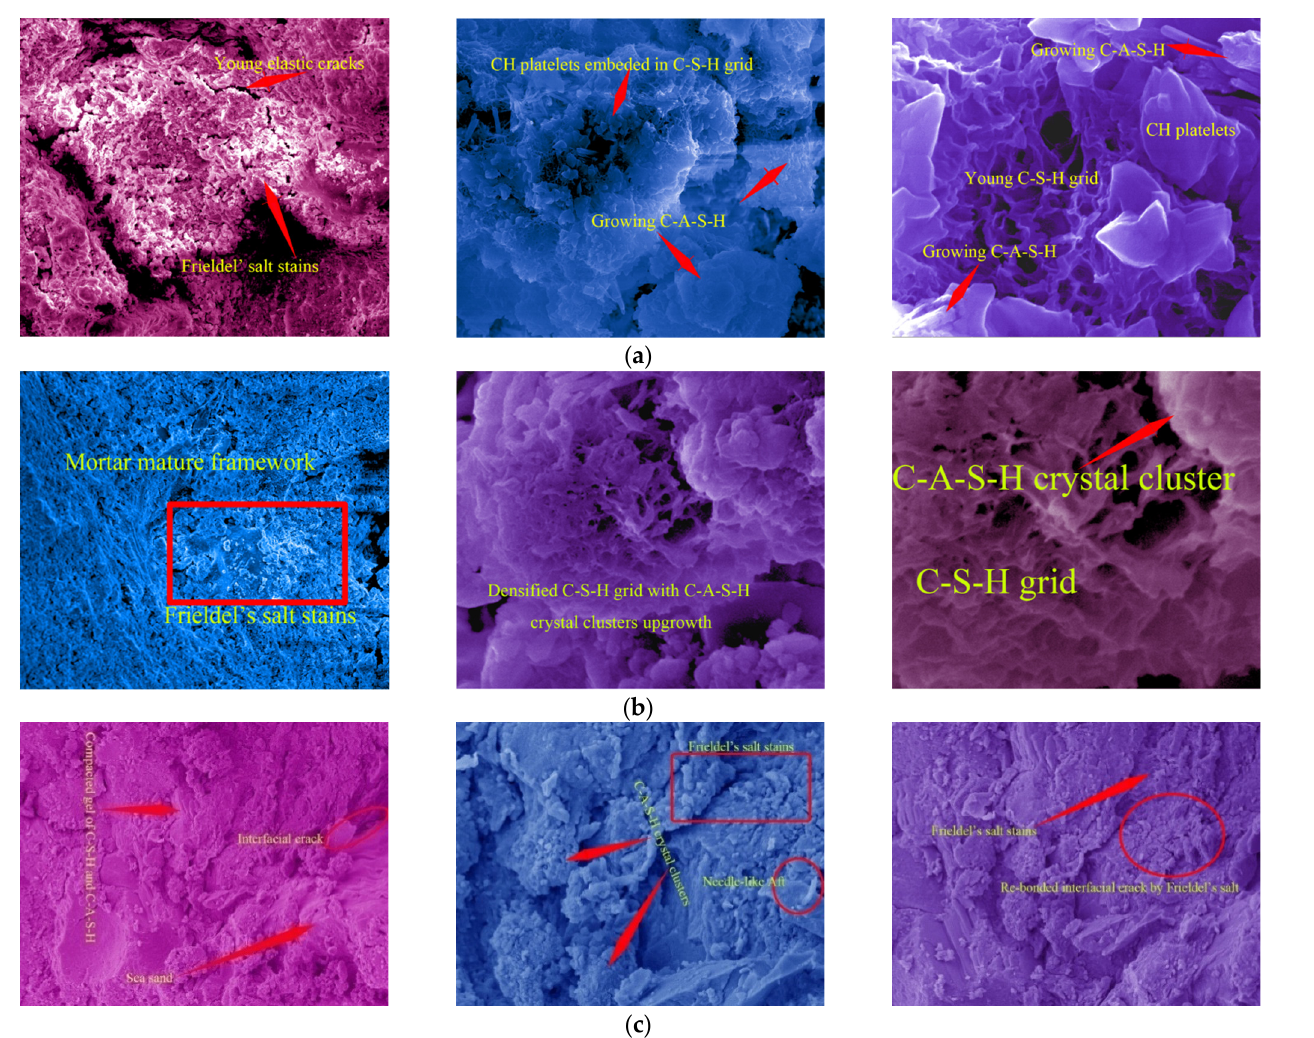
Figure 14. Mortar SEM images. ( a ) Results at 10 days old. ( b ) Results at 33 days old. ( c ) Results at 91 days old.